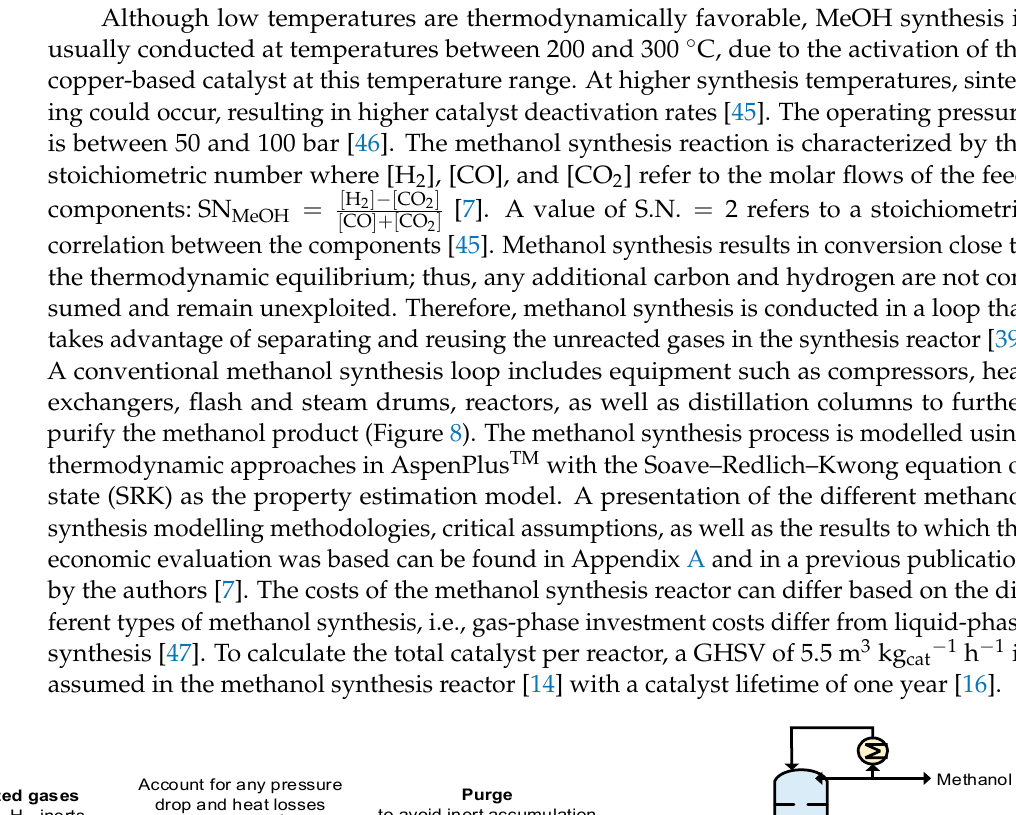
Figure 7. Methanation process flowsheet.